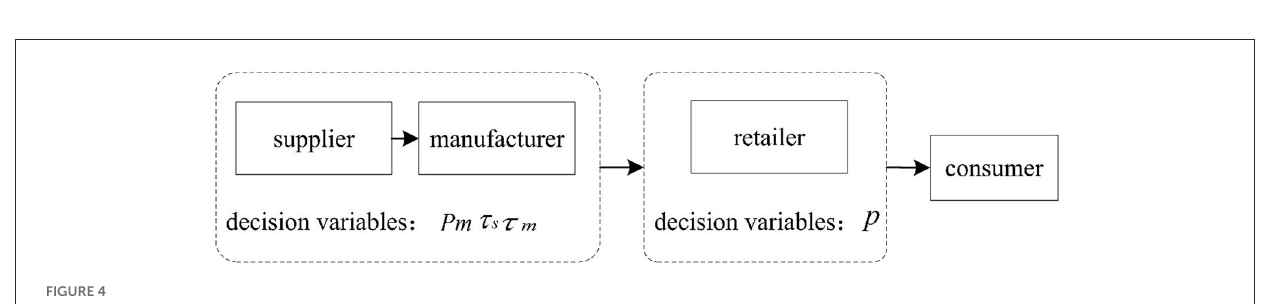
FIGURE4 Supply chain model under the scenario